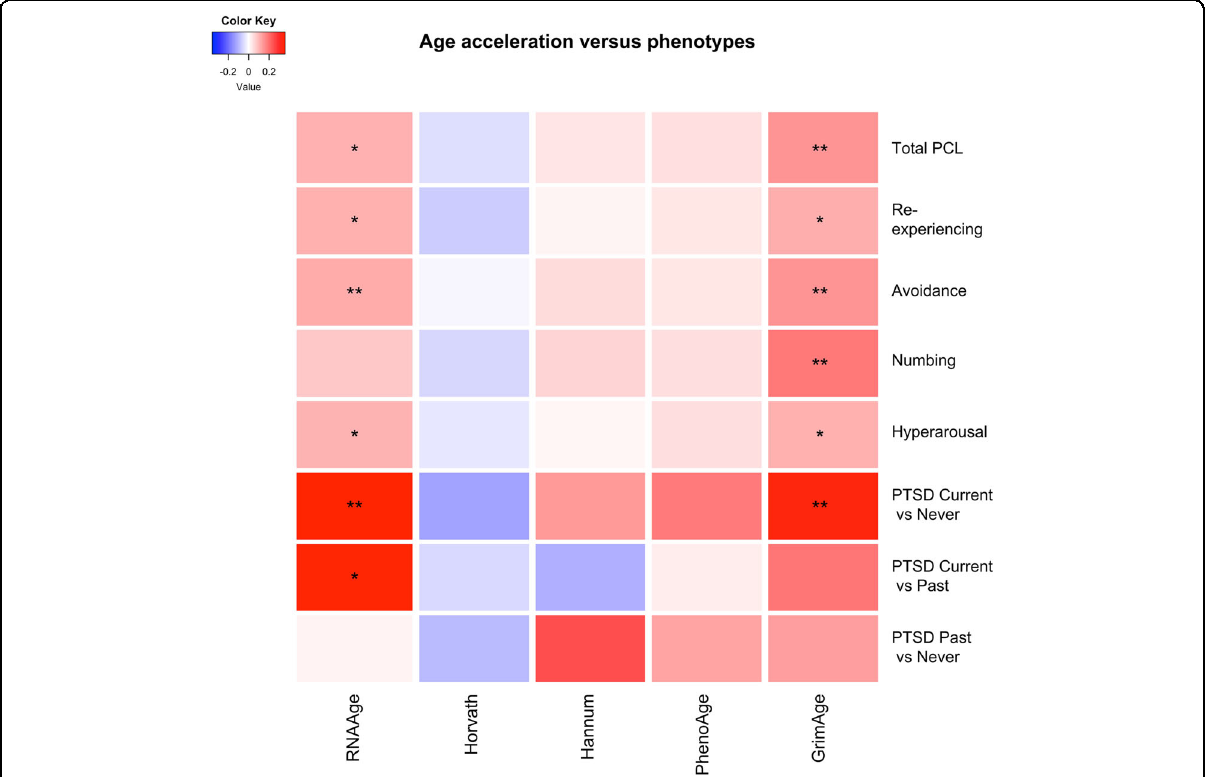
Fig. 3 Heat map summarizing the associations between each of the four DNAm age acceleration (column) and PTSD (row) after adjustment for age and race. The color of each cell represents the magnitude of the standardized coef fi cient β , whereas asterisks indicate p value ranges, i.e., ** p < 0.05; *0.05 < p <